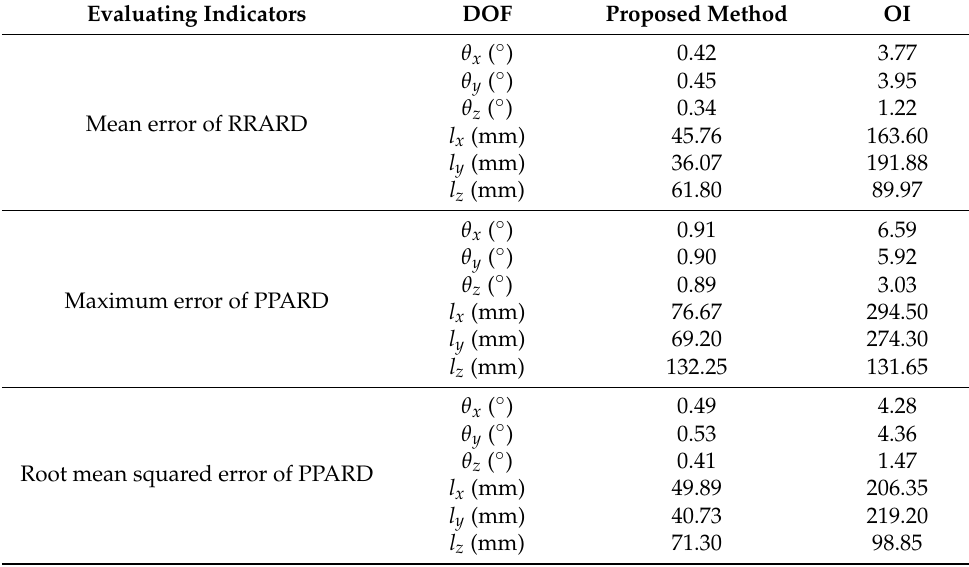
Table 2. Statistical indicators of PPARD estimation results.